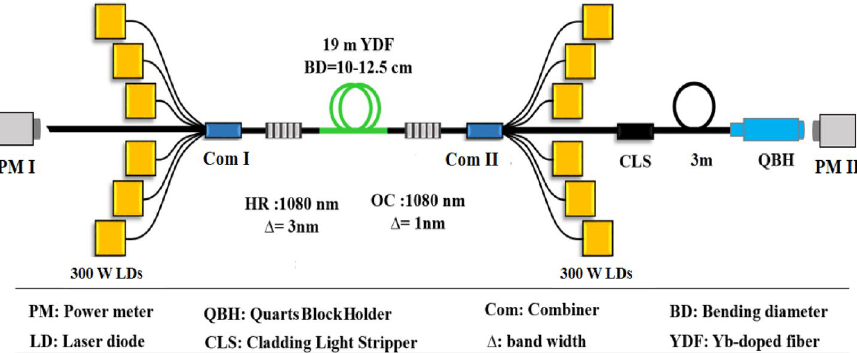
Figure 1. Schematic diagram of the bidirectional pumped